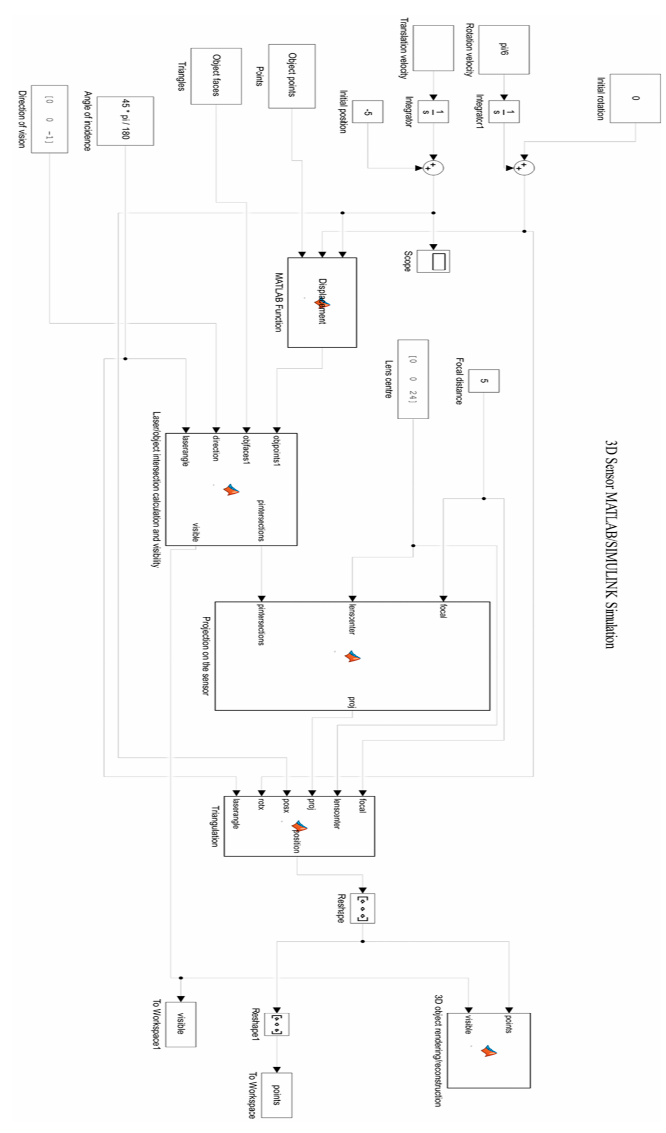
Figure 3. Structure of the SIMULINK simulation model with all its component blocks.